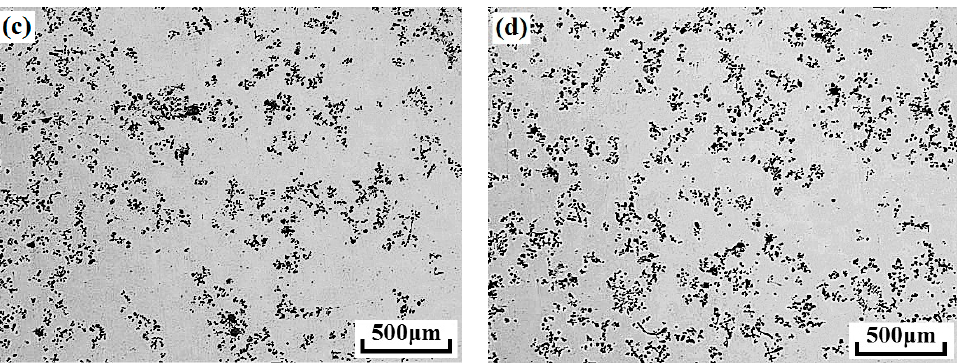
Figure 8. Microstructures of Cu ‐ 14Fe alloys solidified with various stirring models requires continuous stirring at the ( a ) edge and ( b ) center with alternating stirring at ( c ) the edge and ( d ) the center.